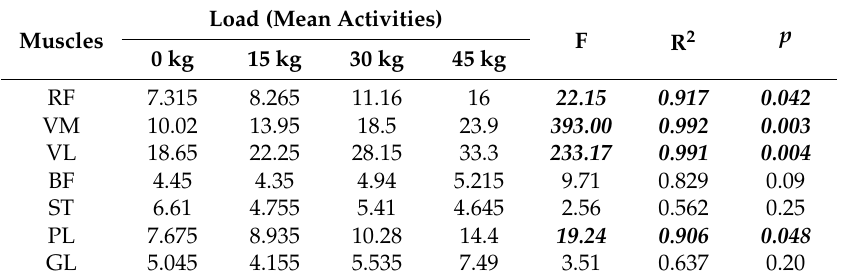
Table 1. Mean Muscle Activities During 0 kg, 15 kg, 30 kg, and 45 kg Load Levels Without the Exoskeleton. ( Note: The determination coefficient R 2 and the statistics F of Fischer used to confirm the linearity in whole cases are shown. The bold and italic style indicates linearity .)